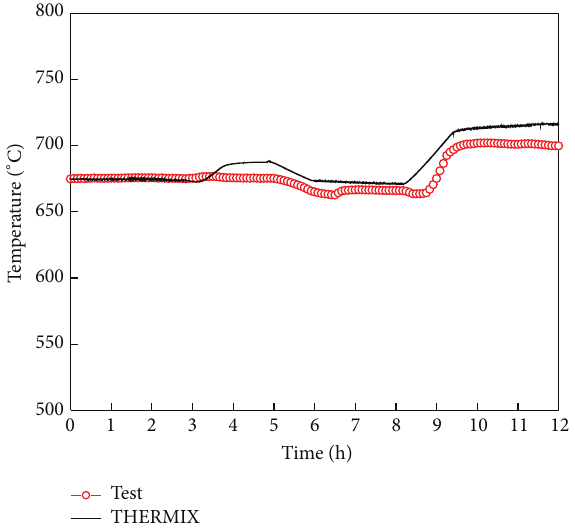
Figure 7: Reactor power during the test.